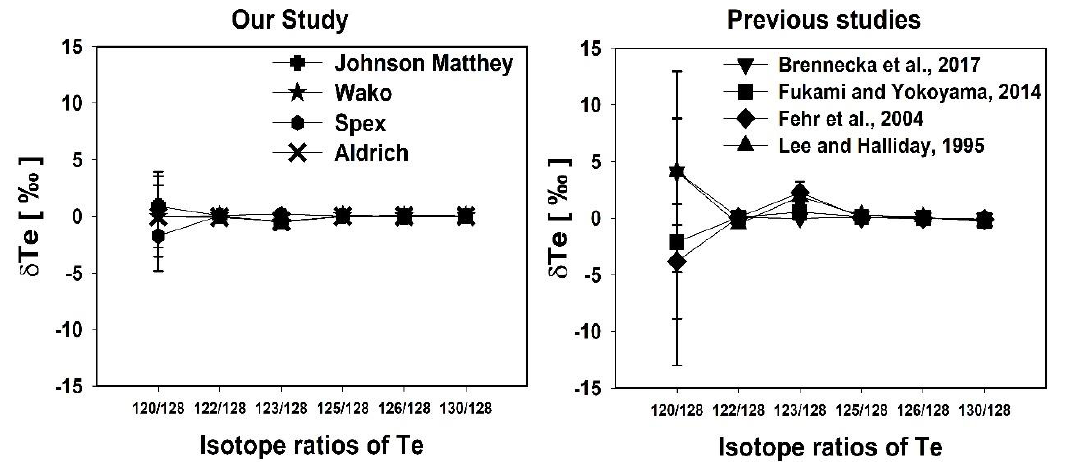
Figure 6. Results obtained for δ 120/128 Te, δ 123/128 Te, δ 125/128 Te, δ 126/128 Te, and δ 130/128 Te of this study was compared with the previous studies in-house Te standards. The error bars (2SD) denotes the external reproducibility of the measurement.